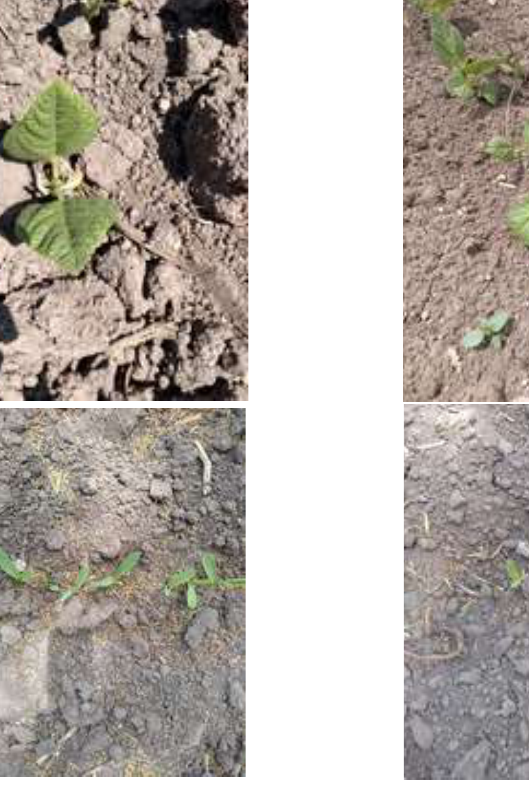
state of the plots during regular visits no later than 10 days after emergence.